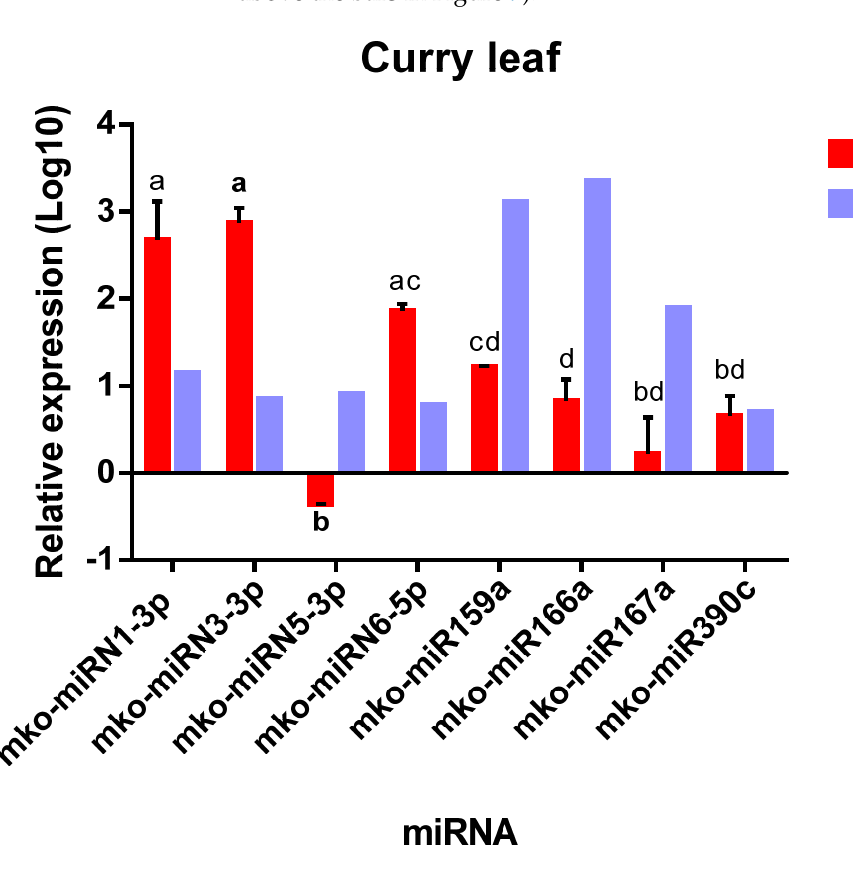
Figure 9. Quantitative PCR analysis of conserved and novel miRNAs of M. koenigii . The relative expression (Log10) of 4 conserved and 4 novel miRNAs was detected by qPCR. U6 was used as an endogenous control. The expression level of miR156a-5p was set as control and taken as 1, and the expression level in all other miRNAs was quantified relative to it. The analysis was performed as triplicates, and the error bars indicate standard deviations. Significant differences between miRNAs at p < 0.05 by ANOVA and Tukey’s test are indicated with different letters.